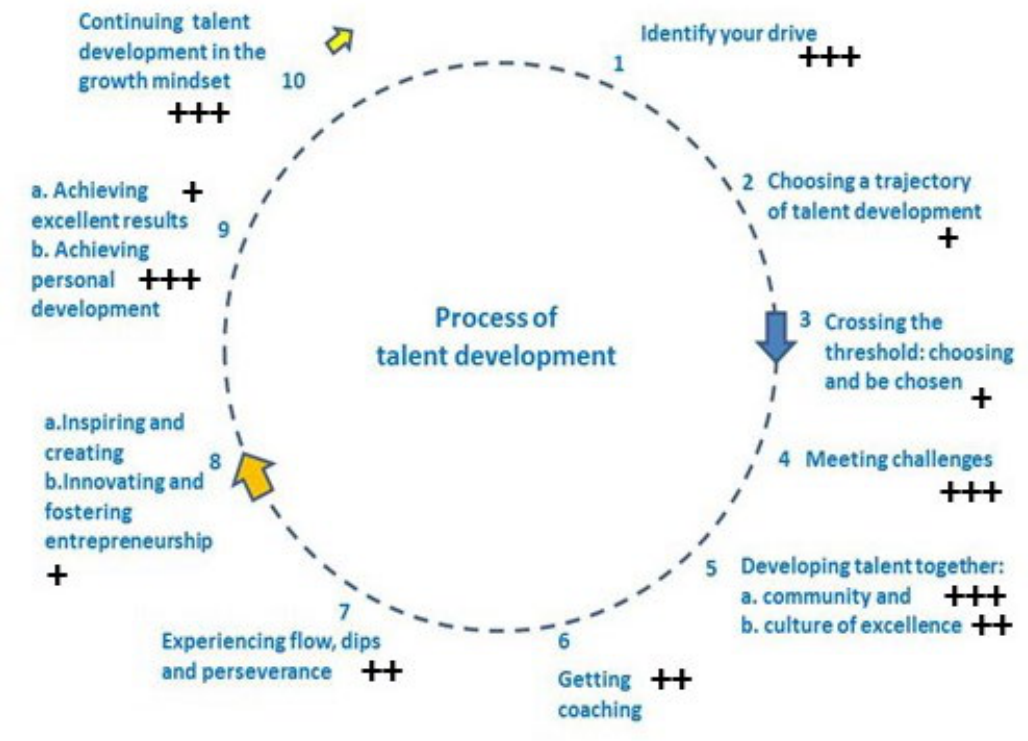
Figure 1. Circle of Talent Development in relation with the good practice ‘Honors course Personal Leadership’ with the teacher’s